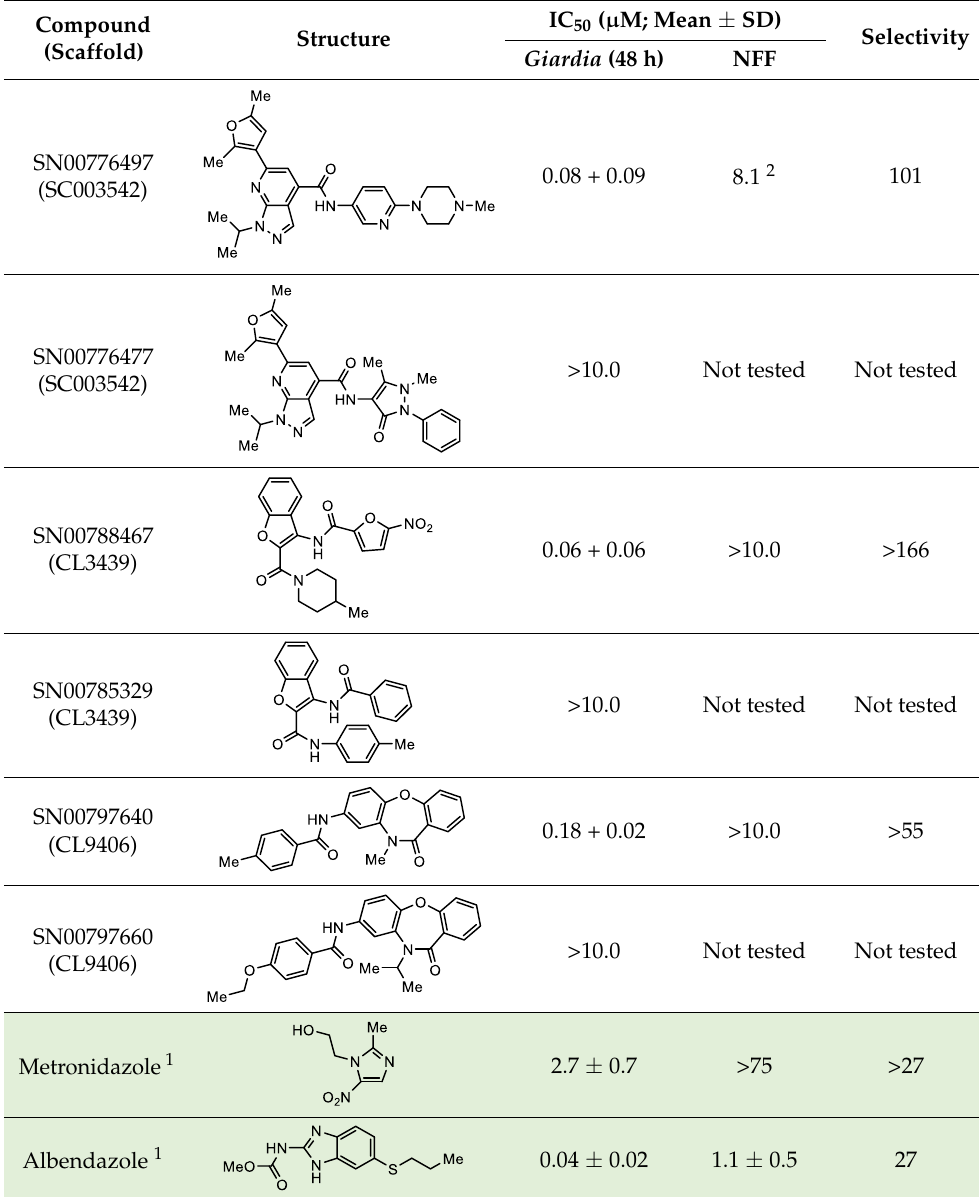
Table 1. The activity of subset compounds within scaffold sets that contained at least one member with a sub-µM IC 50 against Bris/91/HEPU/1279.